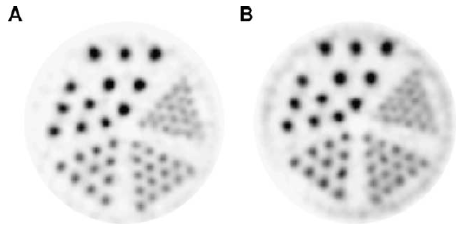
Figure 2. Comparison of image quality of 18 F ( A ) and 45 Ti ( B ) using a Derenzo phantom. Images published by Vavere et al. [31].